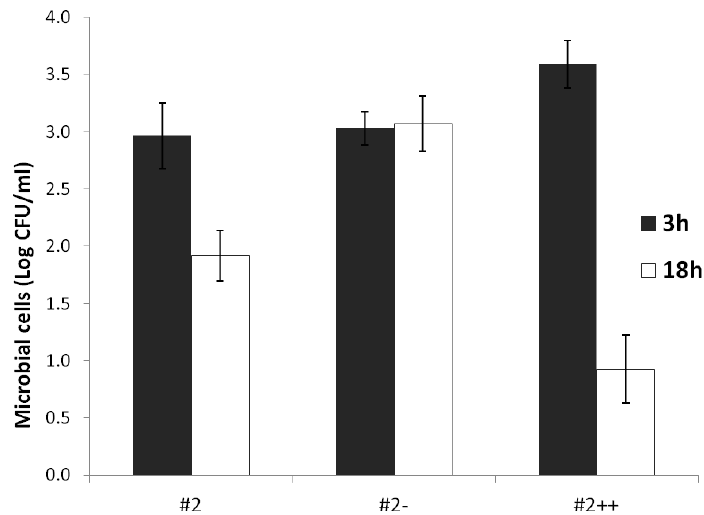
Figure 6. Effect of light irradiation on growth of E. coli O157:H7 on zein/TiO 2 coatings (2%). Sample #2: under light for 15 h and then in dark for 3 h; sample #2 − : under light for 3 h and then in dark for 15 h; sample #2 ++ : replacing TiO 2 with codoped-TiO 2 , under light for 3 h and then at dark for 15 h. After 3 h (black column) and 18 h (white column) of irradiation, fractions were taken, processed for bacterial survival. Error bars represent the standard deviation of the mean.